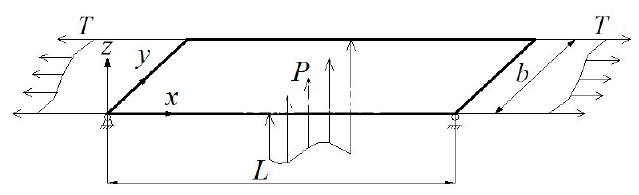
Figure 2. A schematic diagram of the strip dynamic model.